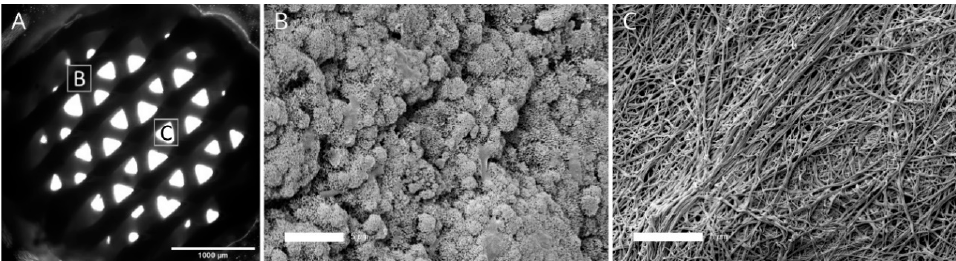
Figure 1. Brightfield image ( A ) of the biphasic calcium phosphate cement (CPC) -fibrin scaffolds with the positions of the subfigures B and C and the microstructure of CPC ( B ) and fibrin ( C ), observed by scanning electron microscopy. Scale bars: 1000 µm ( A ) and 5 µm ( B , C ).